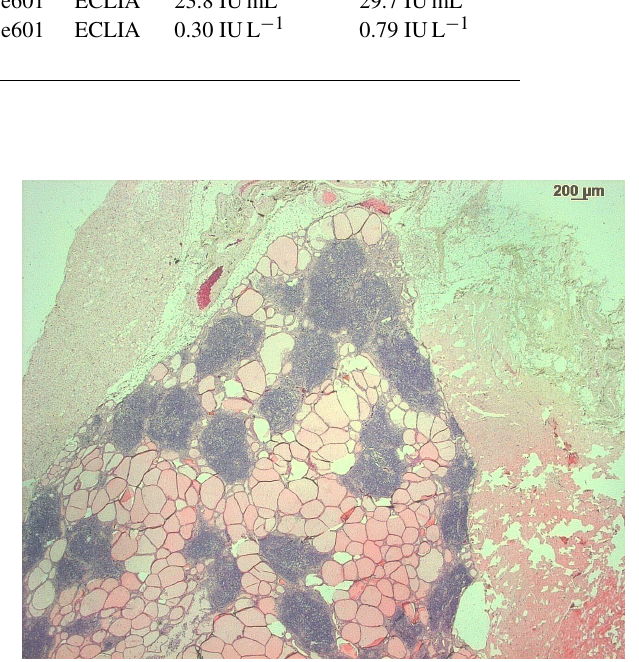
Figure 2. H&E stain of the thyroid gland of a rhesus macaque with chronic lymphocytic thyroiditis: the thyroid gland is disrupted by multifocal to coalescing foci of lymphocytic inflammatory infil-